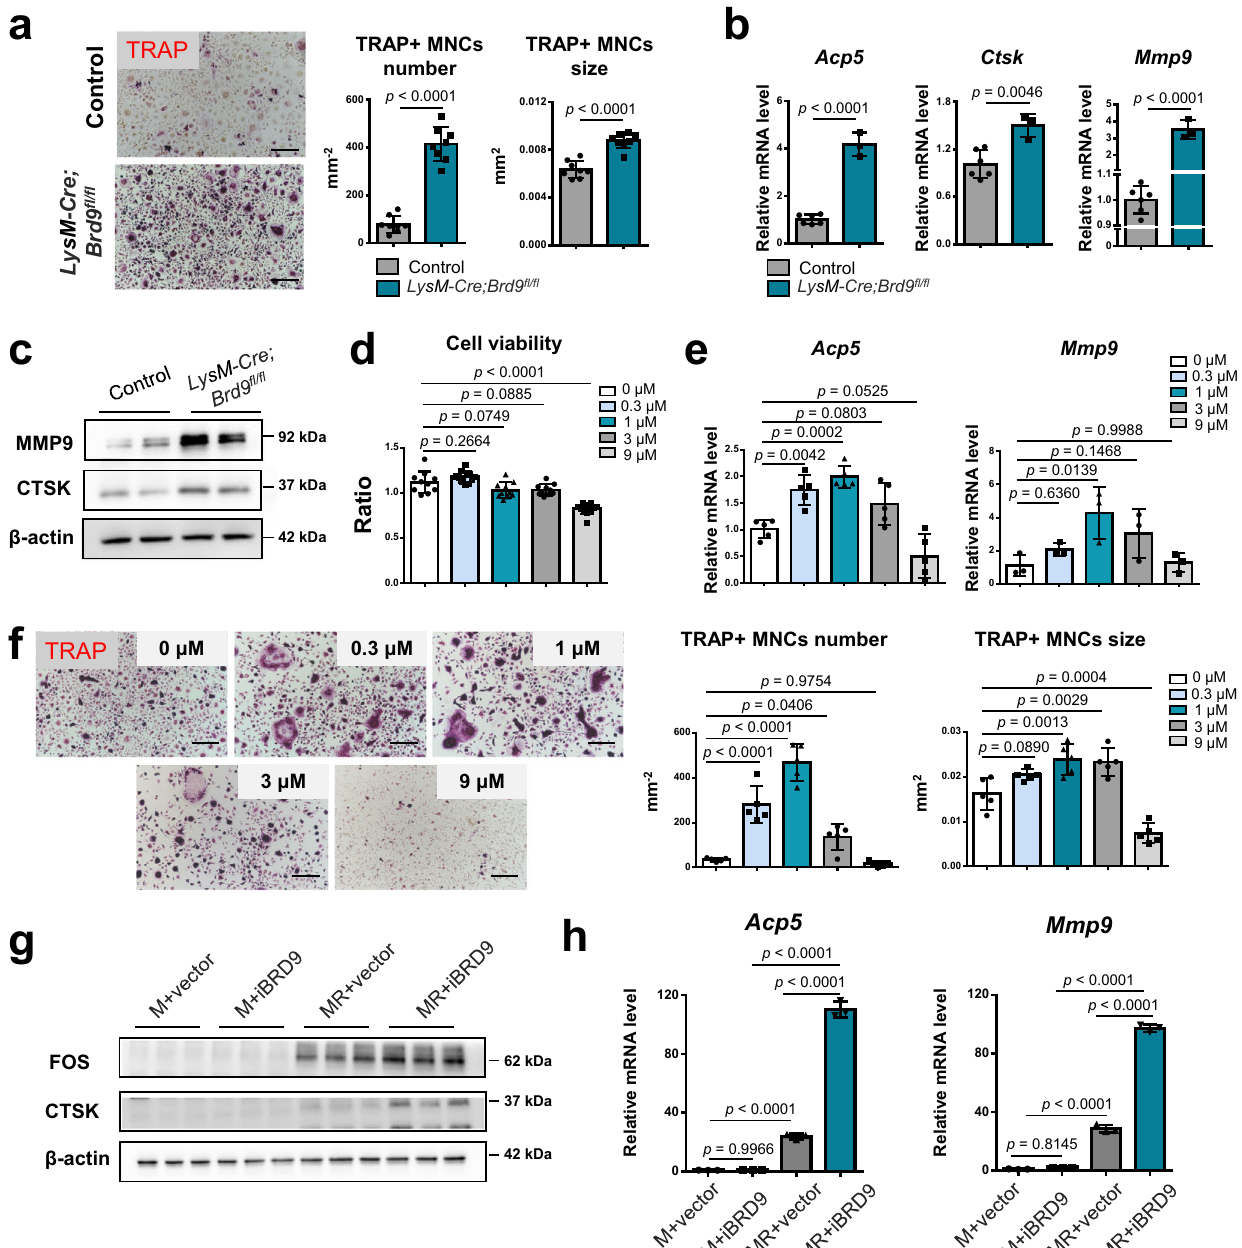
Fig. 3 | BRD9 deletion and inhibition in BMDMs leads to overactivated osteo- clastogenesisinvitro.a TRAPstainingandquanti fi cationanalysisofBMDMsfrom 4-week-old LysM-Cre;Brd9 fl / fl mice and littermate control mice after 3 days of RANKL-induction.Scalebar,200 μ m. n =8. b ThemRNAexpressionofosteoclastic- speci fi c genes of Acp5 , Ctsk, and Mmp9 in BMDMs from LysM-Cre;Brd9 fl / fl mice compared with that from control littermates after 3 days of RANKL-induction, as measured by qPCR. n =3 for LysM-Cre;Brd9 fl / fl mice group. n =6 for control litter- mates. c The protein expression of MMP9 and CTSK in BMDMs from LysM- Cre;Brd9 fl / fl micecomparedwiththatfromcontrollittermatesafter3daysofRANKL- induction, as measured by western blot. d Cell viability of RANKL-induced BMDMs with 1 day of iBRD9 at different concentration, shown by cell counting kit 8 assay. n =10 biologically independent samples. e The mRNA expression of Acp5 and Mmp9 inRANKL-inducedBMDMswith1dayofiBRD9atdifferentconcentration,as measured by qPCR. n =5 biologically independent samples for Acp5 . n =3